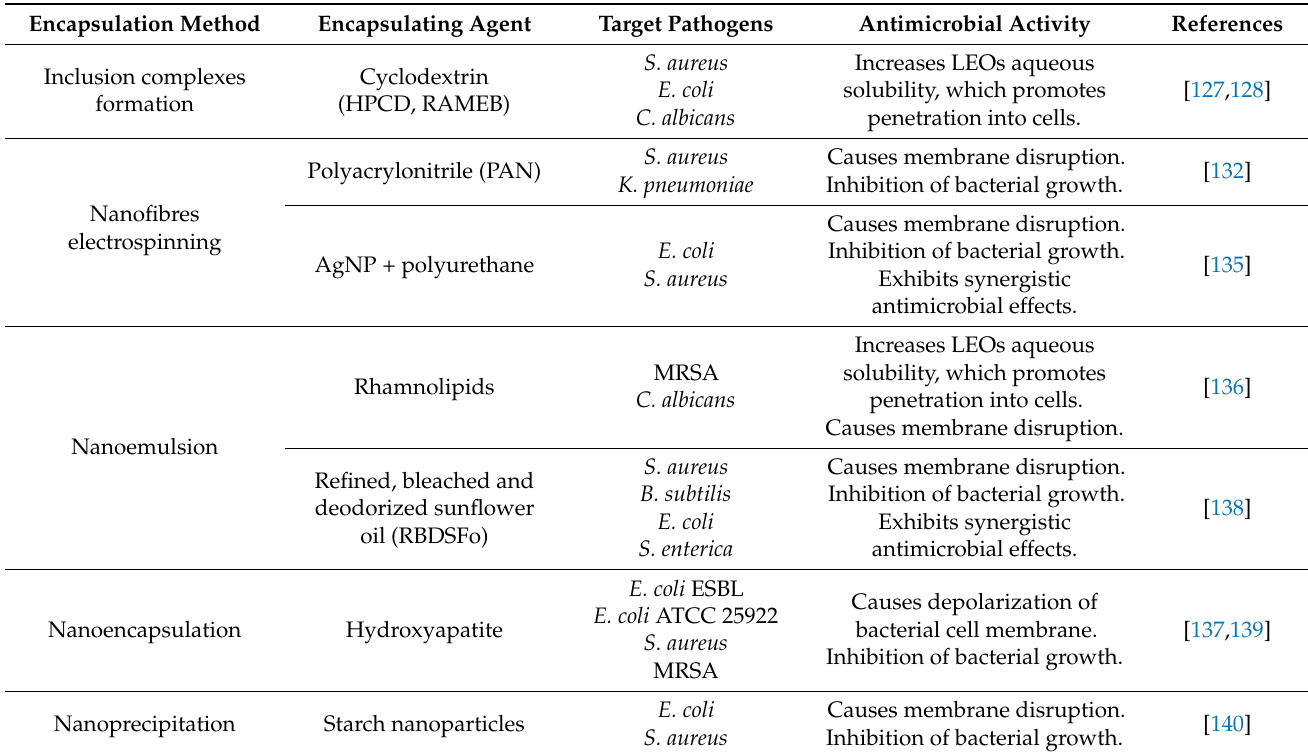
Table 5. The use of LEOs in combination with different nanocarrier systems in boosting their antimicrobial activities. Encapsulation